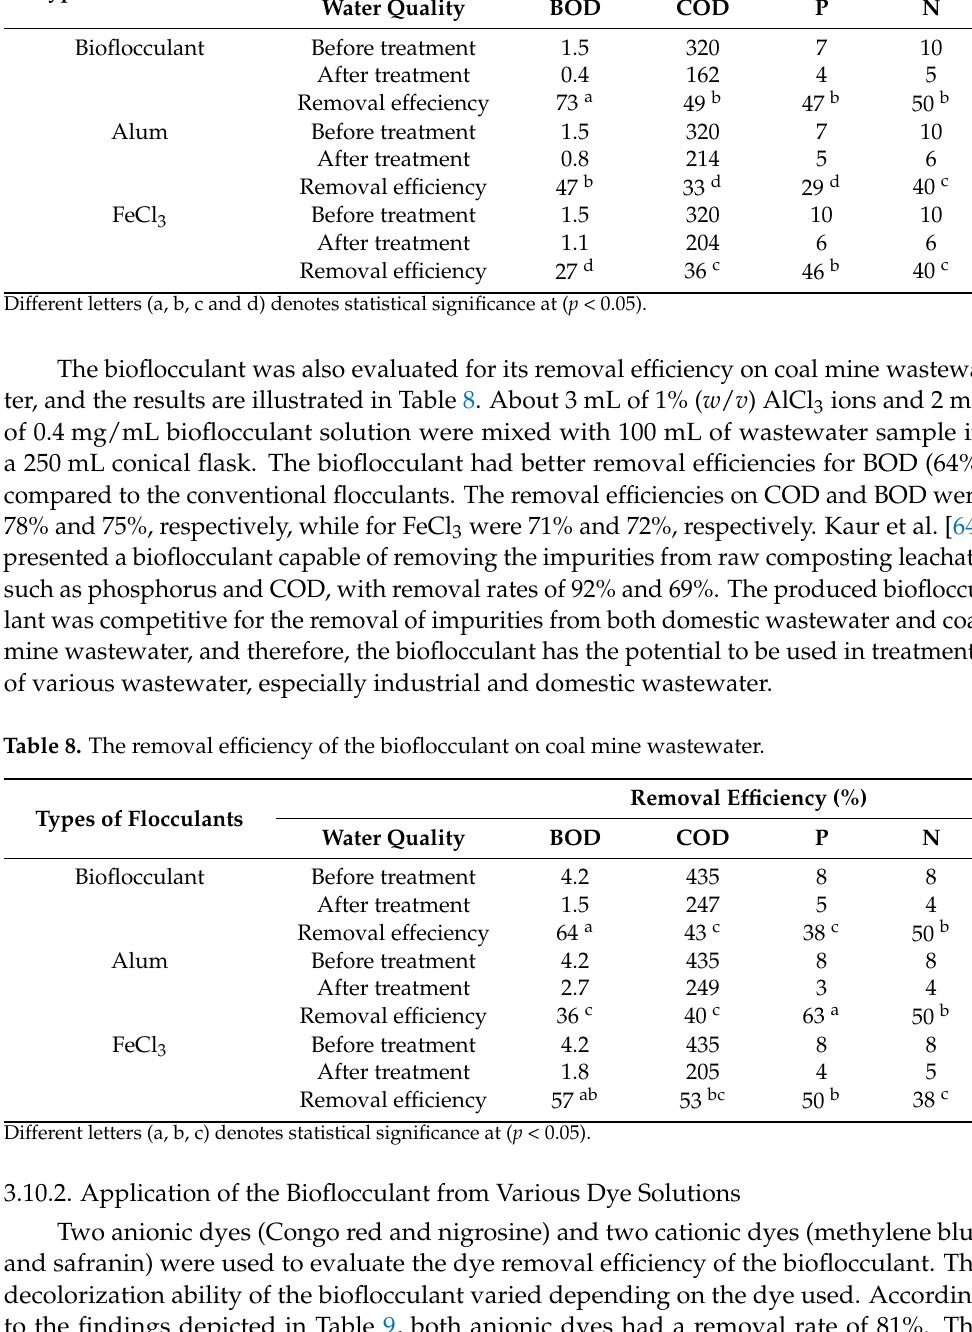
Table 7. The removal efficiency of the bioflocculant on domestic wastewater. Types of Flocculants